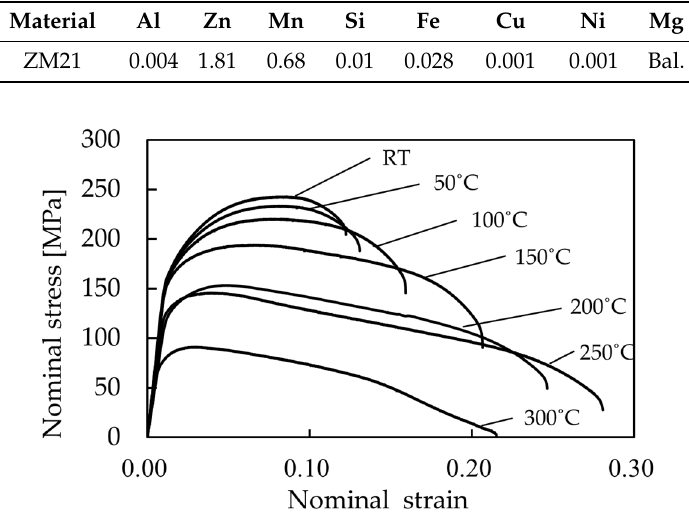
Figure 4. Stress–strain curves of the ZM21 rod obtained from the tensile test result under various temperature conditions.